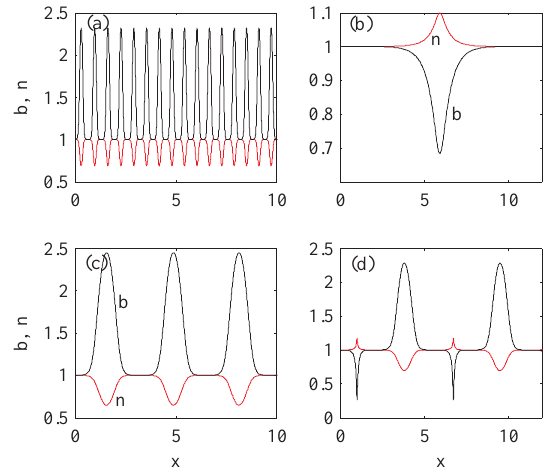
Fig. 3. Phase portrait with growth rate, log (kλ i ) given by Eq. (6), of MHD (including mirror) instabilities in a hot anisotropic plasma for the parameters range from the region of mirror structures ob- served by Cluster ( β ⊥ =11, γ =1.60, κ =0.10, γ a = − 0.62, κ a = − 0.25, a p 0 =0.714). Letters a, b, c, d mark locations of solitons shown in Fig. 4. The asterisk “*” shows the location of mirror structure modelled in Fig. 8. The center region is occupied by non-stationary waves.